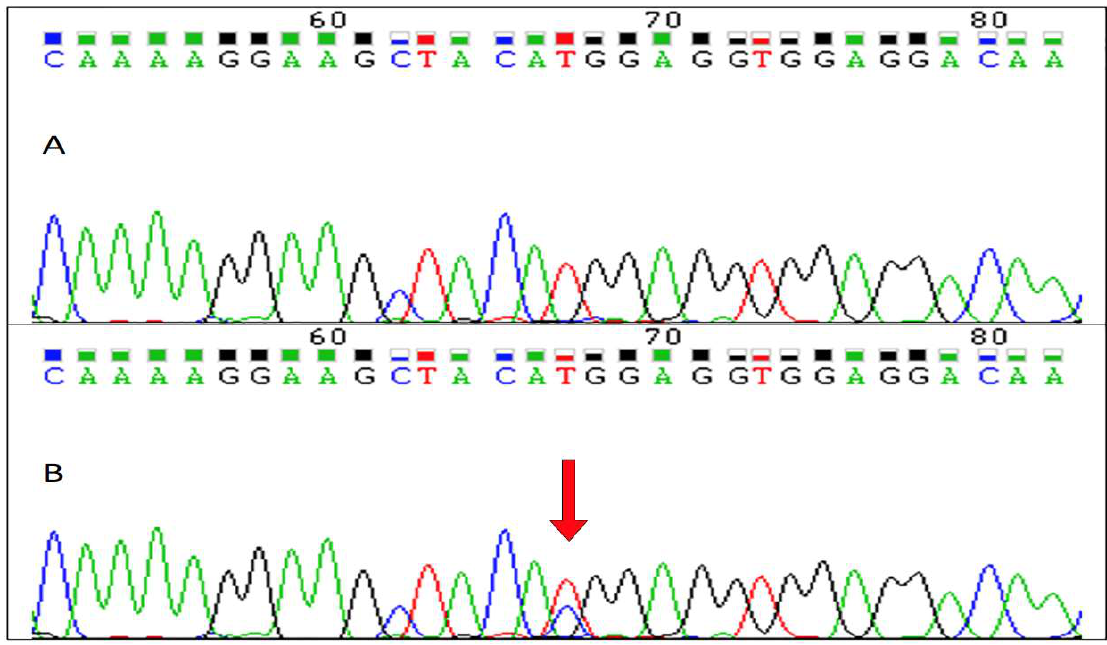
Figure 1. Aquaporin-4 (AQP4) DNA sequence in a wild type and a heterozygous individual. ( A ) DNA sequence electropherogram of a wild type individual showing wild type T at rs 3906956 position. ( B ) DNA sequence electropherogram showing the heterozygous rs 3906956 T > C in the individual with increased water permeability (red arrow).